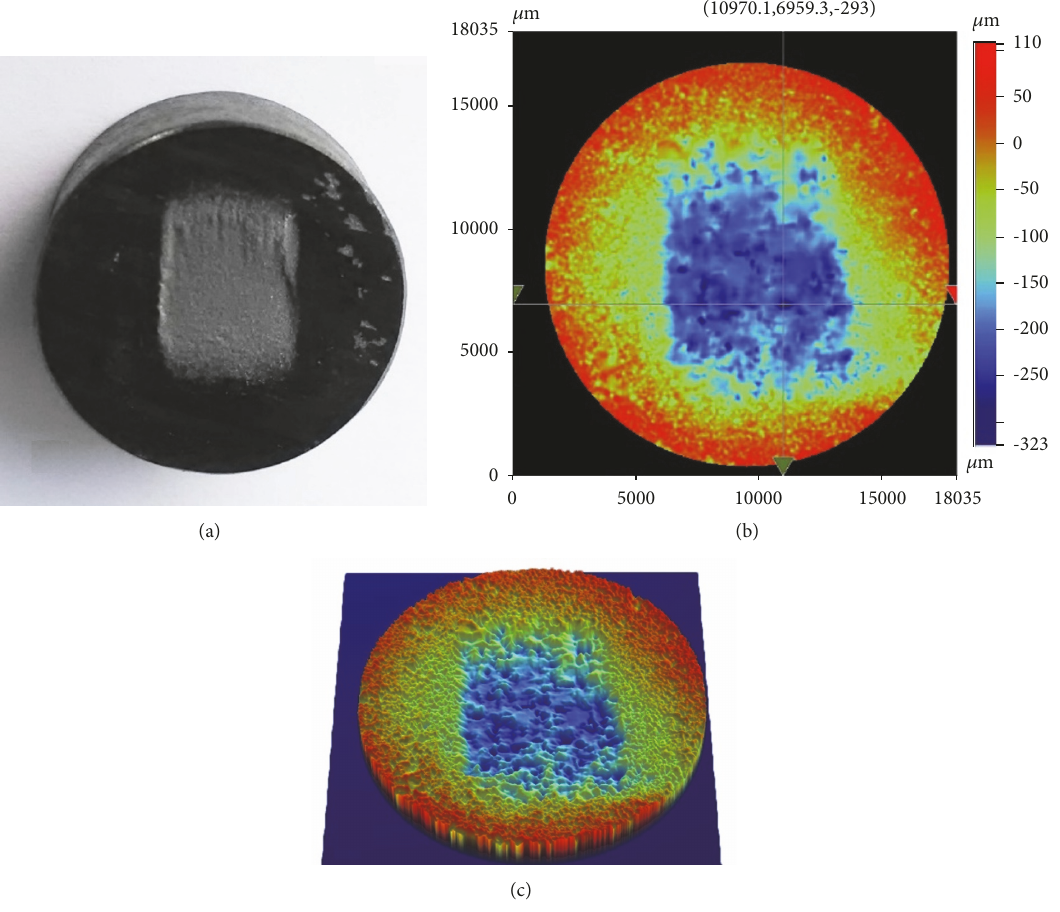
Figure 8: Sample No. 1 after impact-abrasive test (a) photograph, (b) 3D OSP contour micrograph, and (c) 3D OSP perspective micrograph.